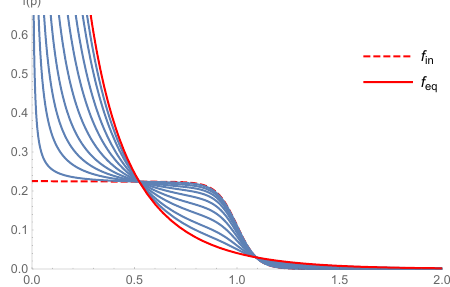
Figure 5. Evolution of the initial condition using the Relaxation Time Approximation. The relaxation time parameter is taken to be 40 in order to match the Fokker-Planck timescale; the intermediate distribution functions shown are for times t ∈ { 0.5,2,4,7,12,20,32,52,80 } .